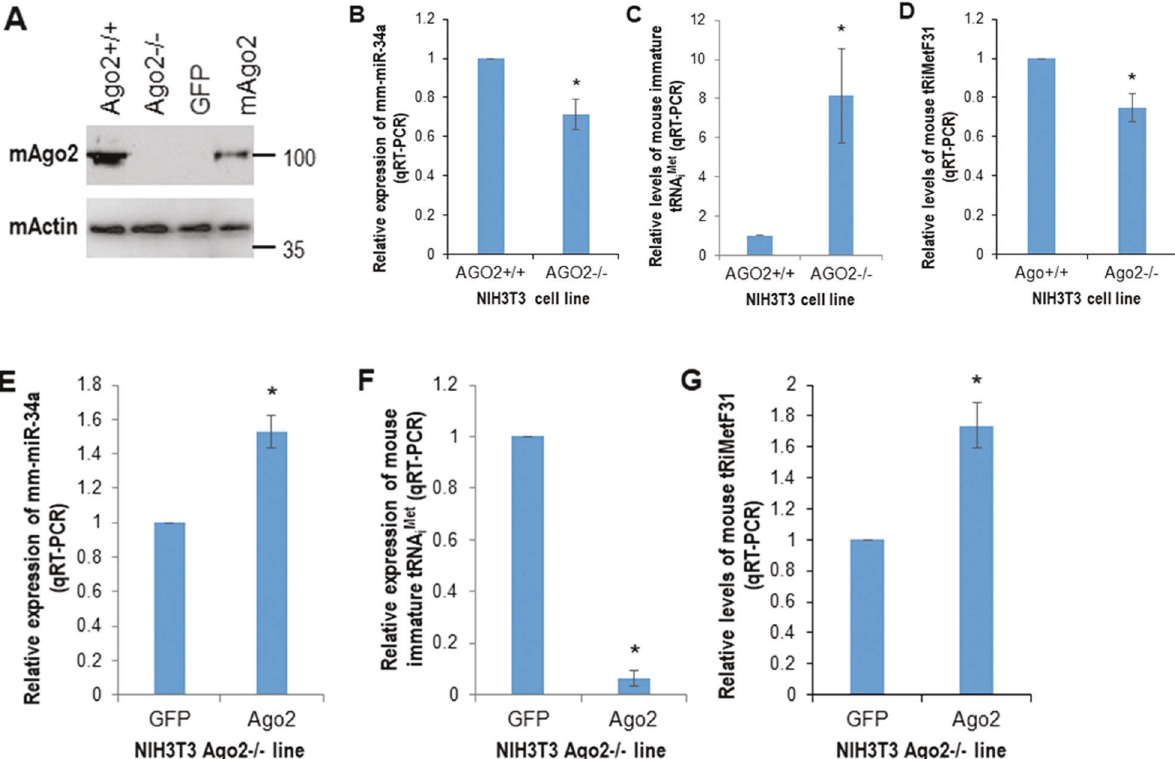
Fig. 2 AGO2 is a key molecule in regulating the expression levels of miR-34a and tRiMetF31. A Whole cellular lysates prepared from mouse NIH3T3 AGO2 wild-type (Ago2 + / + ), AGO2 knockdown (Ago2 − / − ), and Ago2 − / − cells transfected with GFP or mouse Ago2 (mAgo2) were subjected to western blot analysis using antibody to mouse Ago2. B – D Total RNA isolated from Ago2 + / + and Ago2 − / − cells was subjected to qRT-PCR analysis using primers for mm-miR-34a, immature tRNA iMet and tRiMetF31. E – G Total RNA isolated from GFP and mAgo2 cells was subjected to qRT-PCR analysis using primers for mm-miR-34a, immature tRNA iMet , and tRiMetF31. * indicates P <